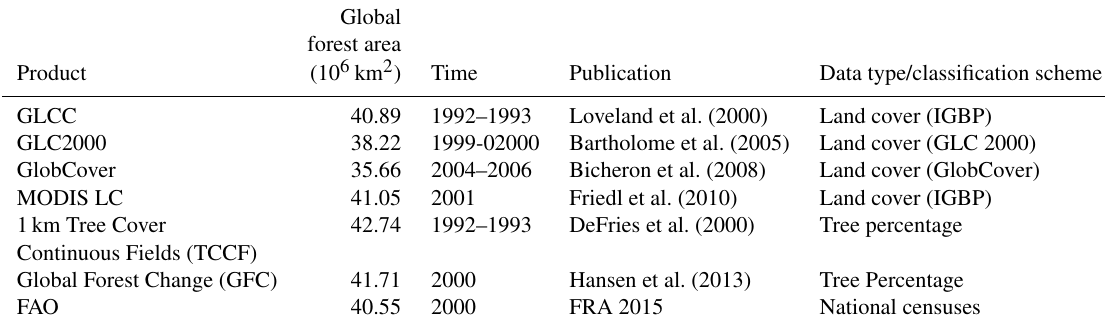
Table 2. Summary of land cover products used in this study including six satellite-based datasets and FAO FRA